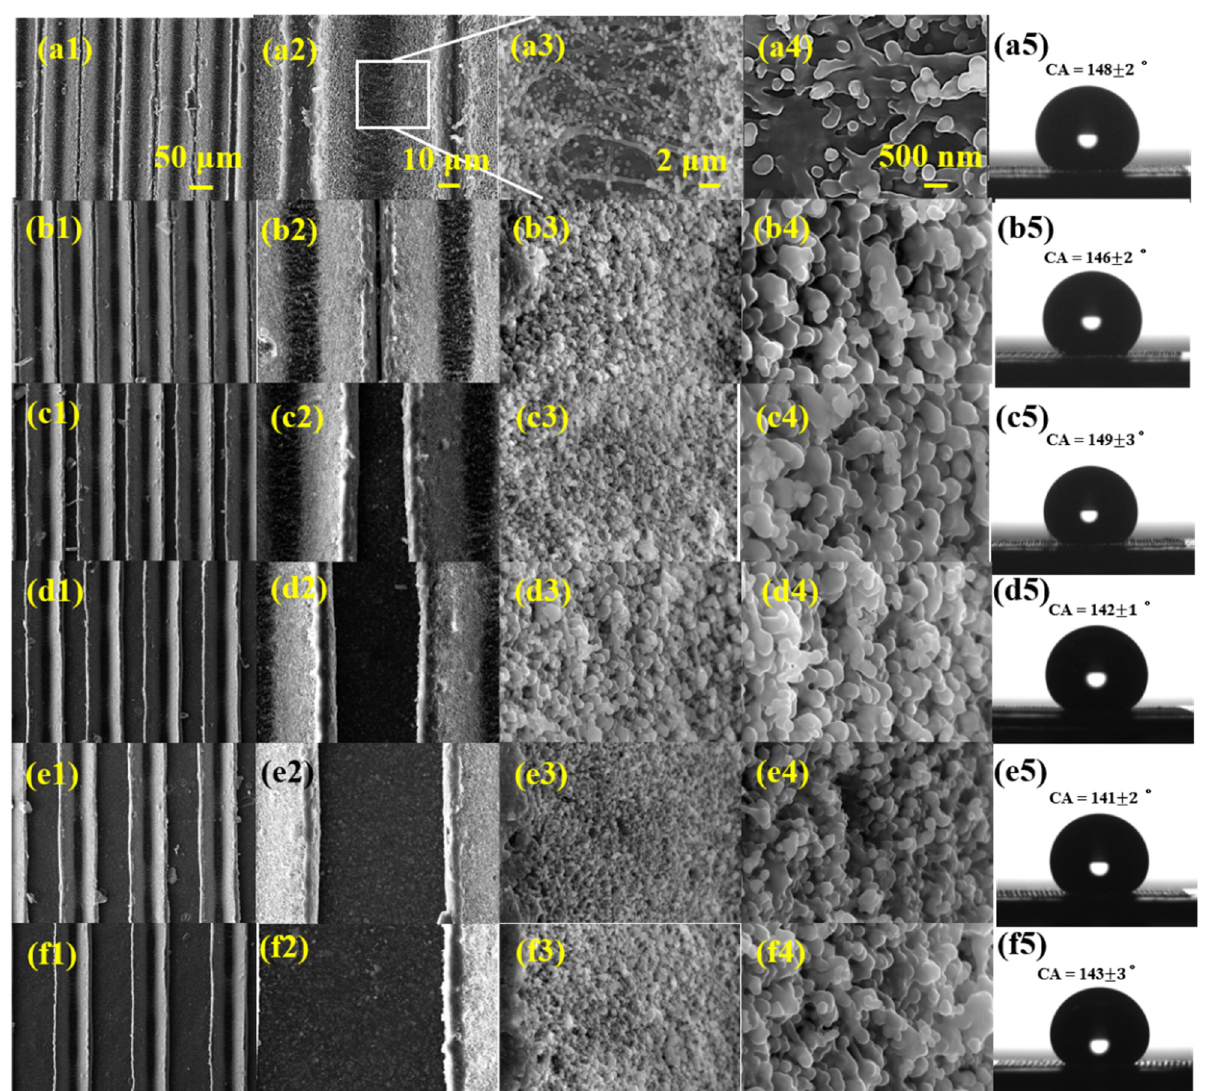
Figure 2. SEM images of groove structure with different spaces and the corresponding contact angle images. ( a1 – a5 ) Shows 60 μ m spacing, CA = 148 ± 2 °, ( b1 – b5 ) 80 μ m spacing, CA = 146 ± 2 °, ( c1 – c5 ) 100 μ m spacing, CA = 149 ± 3 °, ( d1 – d5 ) 120 μ m spacing, CA = 142 ± 1 °, ( e1 – e5 ) 140 μ m spacing, CA = 141 ± 2 °,( f1 – f5 ) 160 μ m spacing, CA = 143 ± 3 °. The laser power density is 3.8 × 10 4 W/cm 2 .